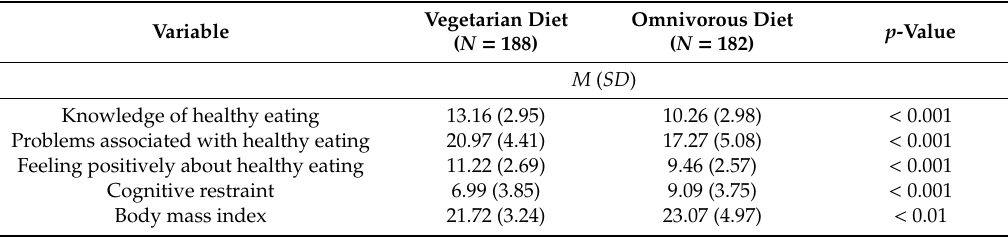
Table 3. Unhealthy eating patterns and body mass index across the dietary